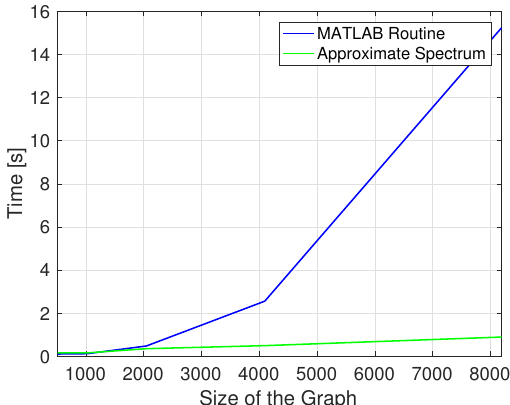
Figure 5. Comparison of the time required by the built-in MATLAB routine for obtaining the eigenvalues of a matrix, and the time required by the proposed algorithm levering a hierarchical